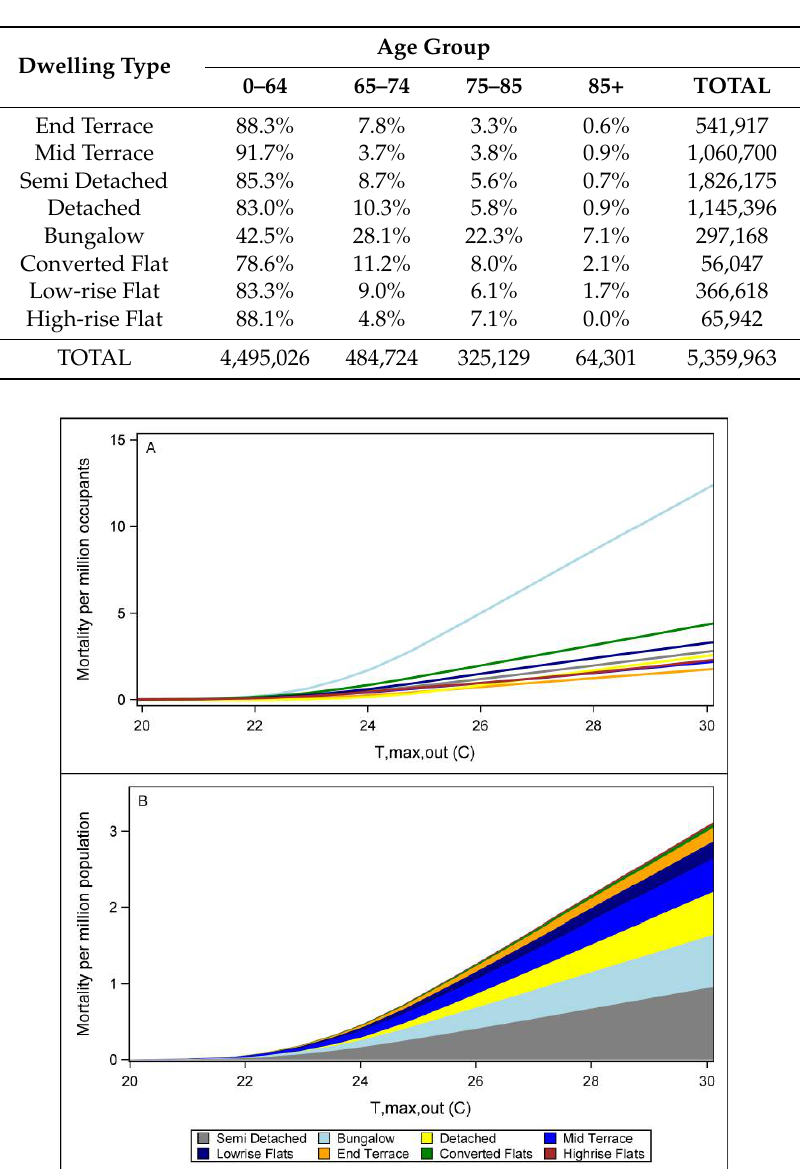
Figure 3. ( A ) The mortality per million occupants per day of each dwelling type at increasing outdoor temperatures; ( B ) The mortality per million population per day in the West Midlands at increasing outdoor temperatures, stacked by dwelling variant.